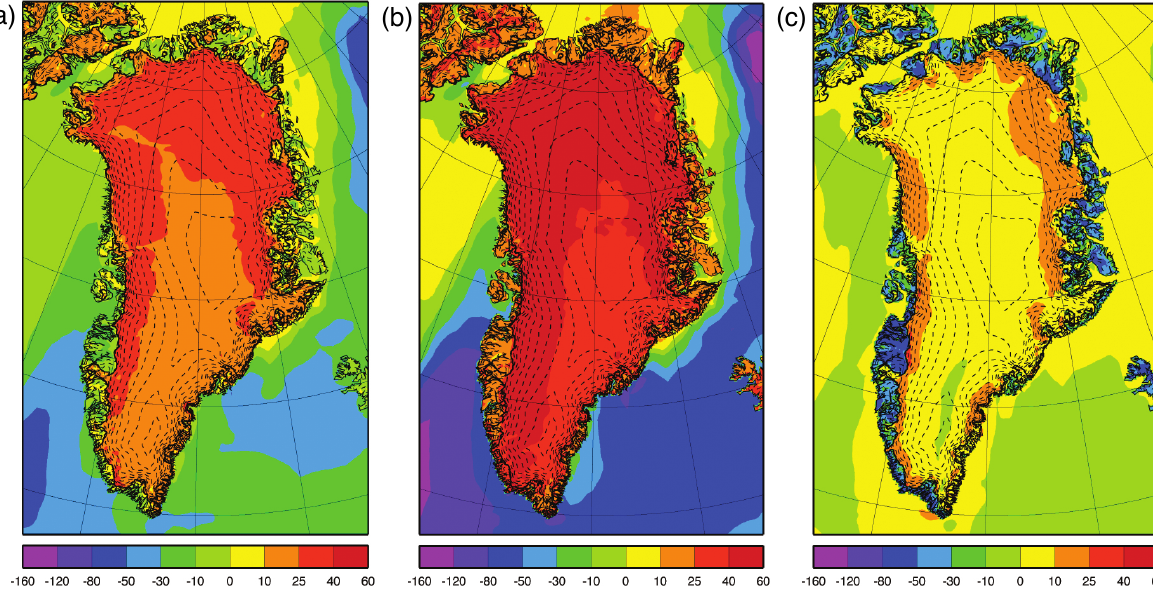
occurs in spring and summer on locations where the snow surface is heated but does not yet